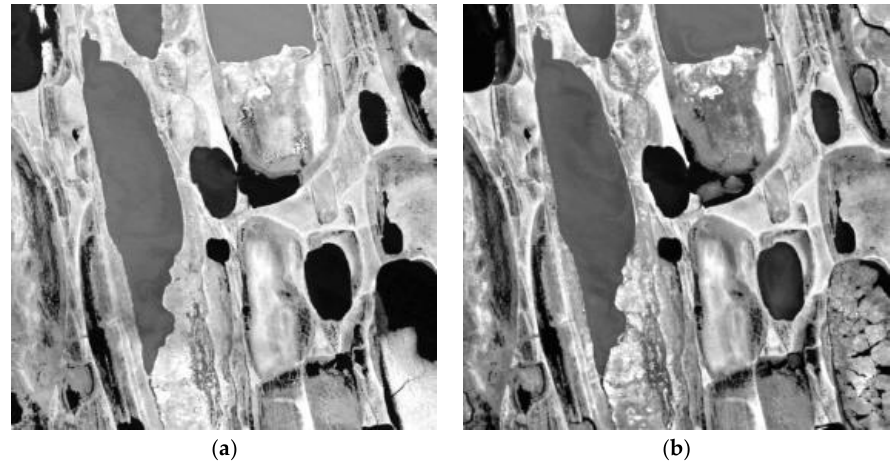
Figure 6. Alaska dataset. ( a ) Image acquired in July 1985. ( b ) Image acquired in July 2005.